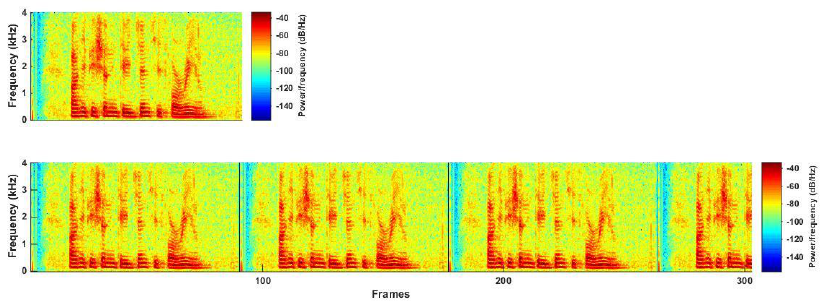
Figure 4. An illustration of the padding method (a).